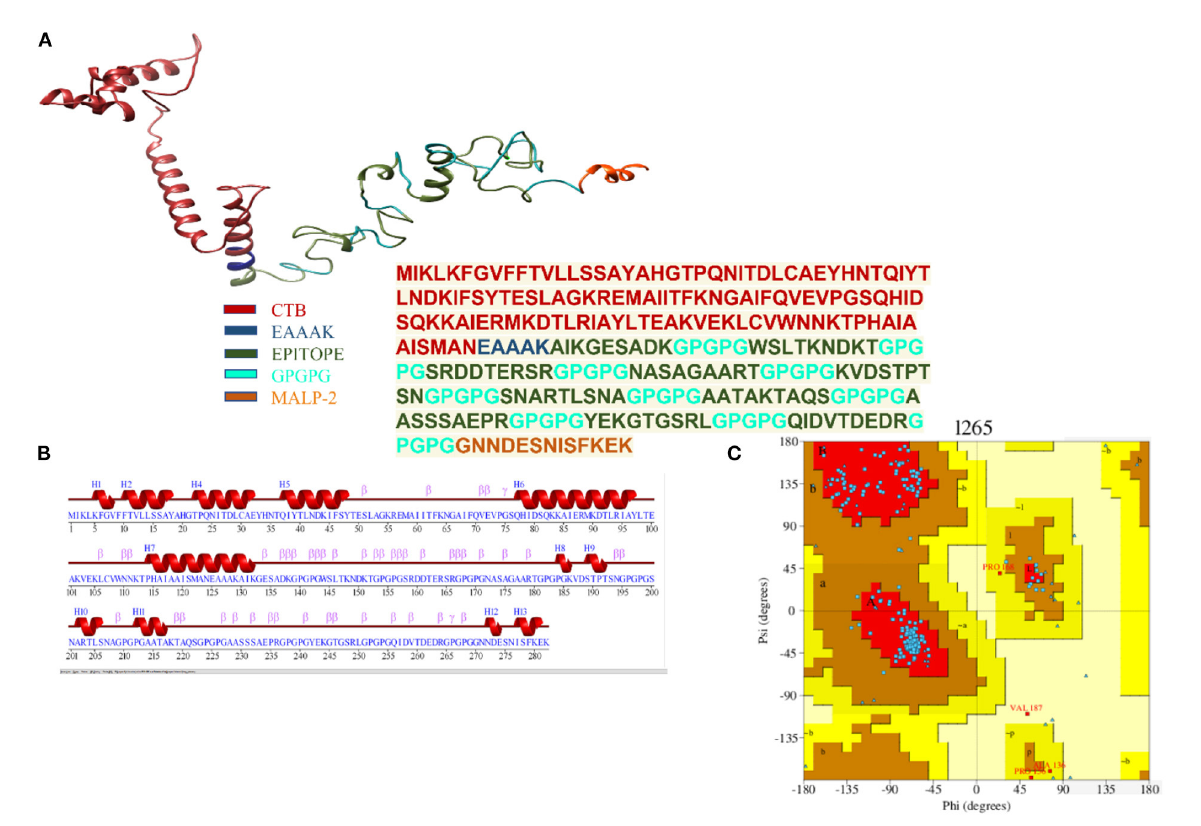
FIGURE6 (A) Depiction of the details of 3D model of the multi-epitope vaccine with peptide sequence for the vaccine construct. (B) Secondary structure for the multi-epitope vaccine. (C) Ramachandran plot showing 92.6% of the residue in most favorable region.